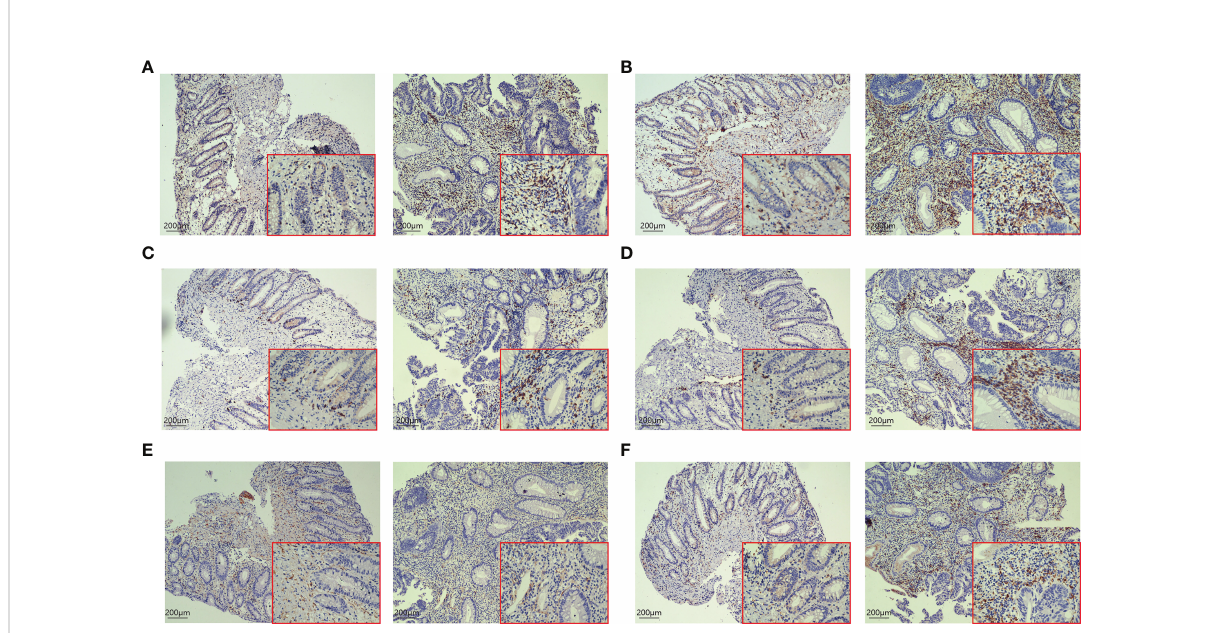
FIGURE 7 IHC staining of tumor tissues in CRC patients before and after 48h of PDT (n=6). Images are shown at 20× magni fi cation; bars indicate 200 µm; the left is before PDT, and the right is 48h after PDT. (A) CD3 + T cells in tumor tissue were increased signi fi cantly after PDT. (B) The number of CD4 + T cells in tumor tissue was increased after PDT. (C) Changes in the number of CD8 + T cells in tumor tissues. CD8 + T cells were increased after PDT. (D) The number of CD20 + B cells goes up after PDT. (E) There was no signi fi cant change in CD56 + T cells. (F) The number of macrophages increased signi fi cantly after